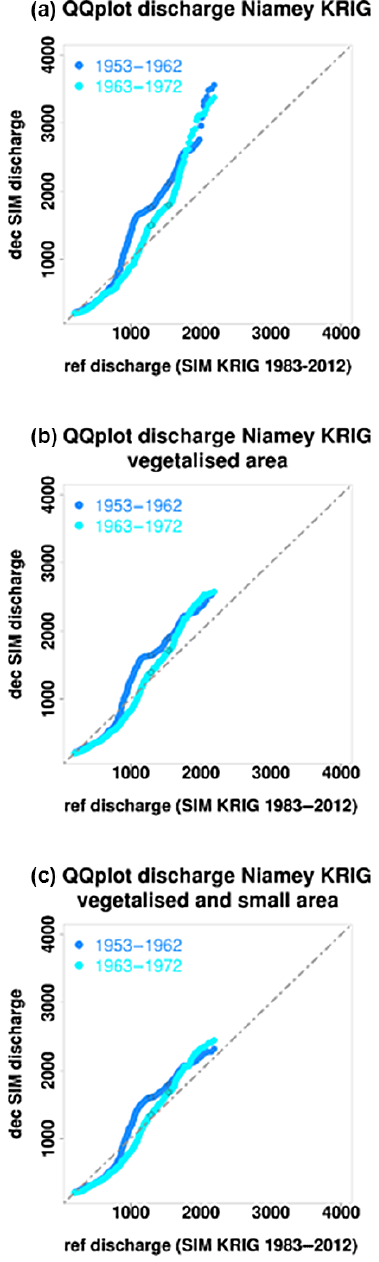
Figure 13. Quantile–quantile plot (Q–Qplot) of daily annual dis- charge of each decade, the reference is daily discharge between 1983 and